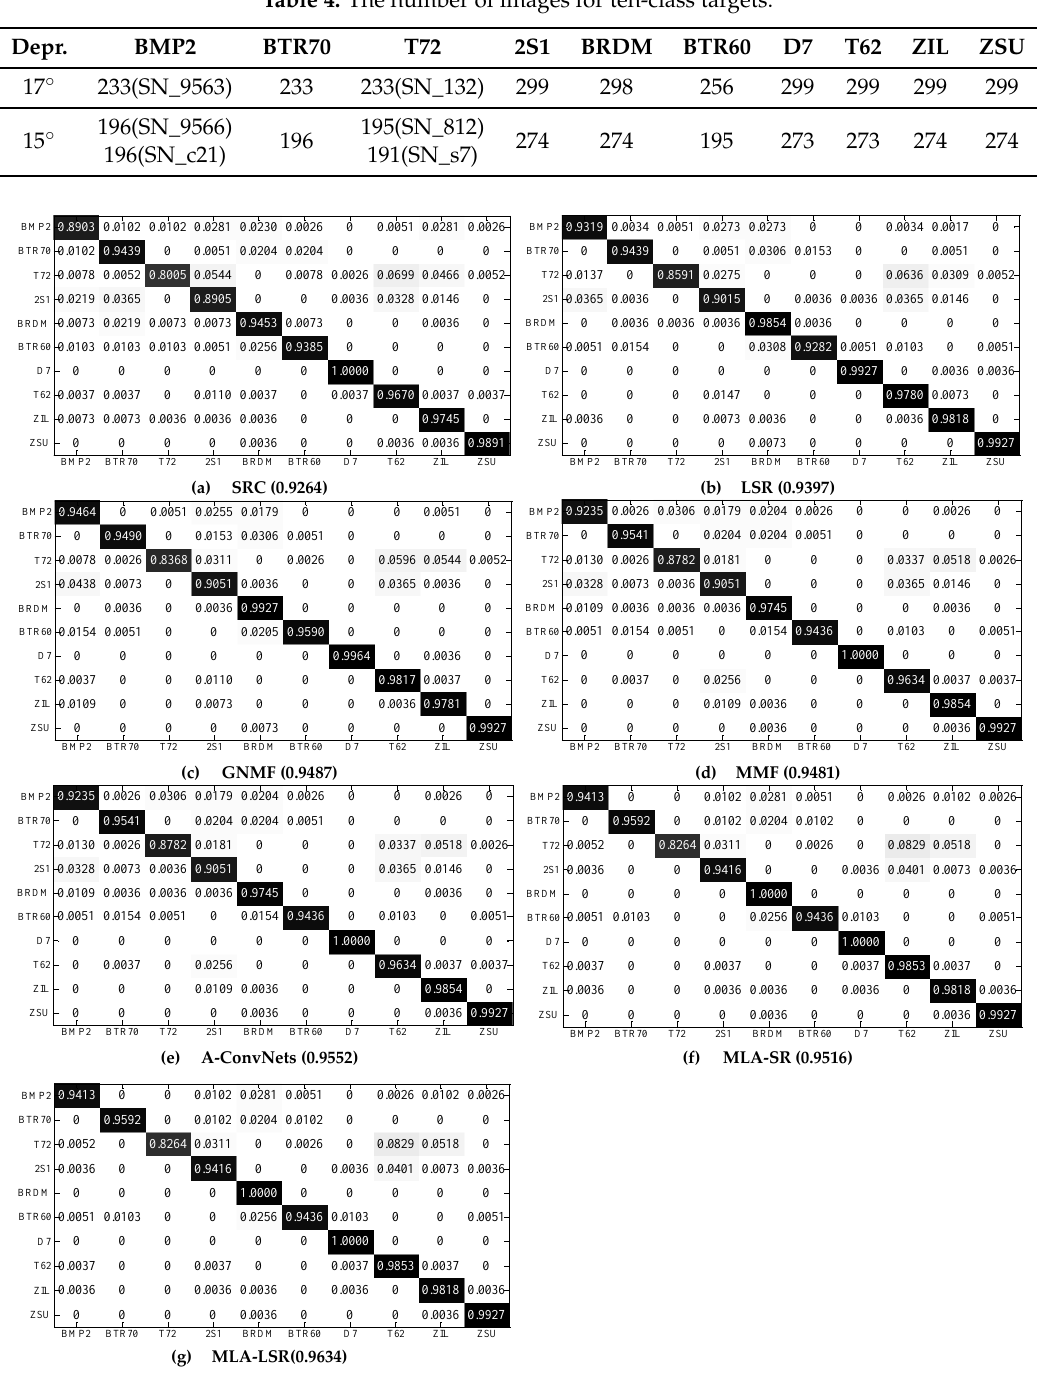
Figure 9. The confusion matrices of SRC, LSR, GNMF, MMF, MLA-SR, A-ConvNets, and MLA-LSR. For each matrix, the entry denotes the percentage of classifying the target in the row as the target in column. The average accuracies are given in